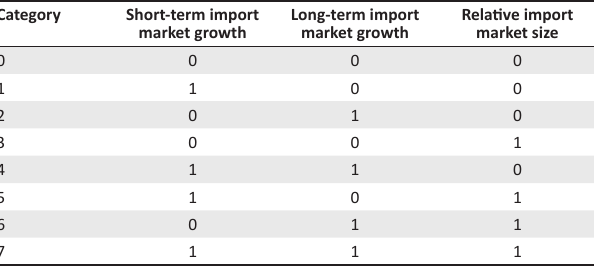
Category Short-term import